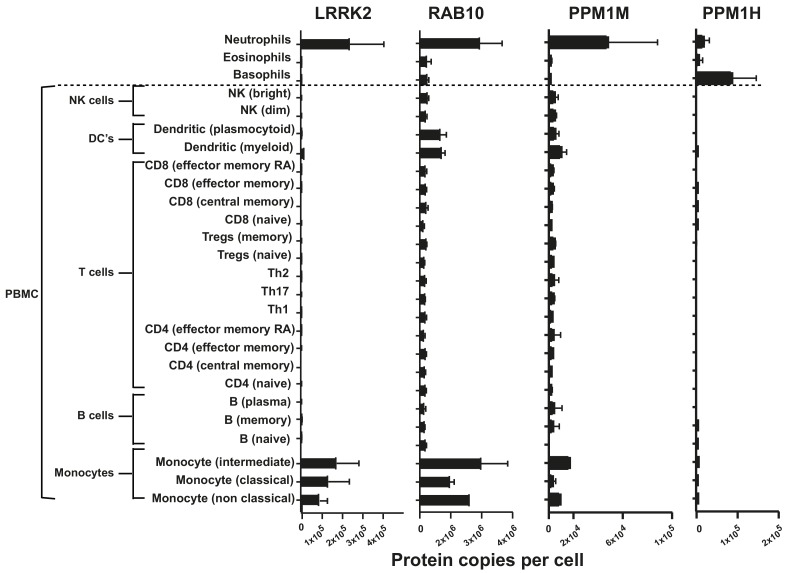
The abundance of PPM1H and PPM1M proteins in immune cells isolated from human blood using data available from the immprot database (http://www.immprot.org) (Rieckmann et al., 2017).The study utilized pure populations of immune cells isolated from human blood using fluorescence-activated cell sorting, and whole cell proteomics data were generated. Data were analyzed using the histone ruler to estimate protein copy numbers per cell. The graphs show the number of protein copies per cell for PPM1H, PPM1M, LRRK2 and Rab10 in a range of peripheral blood immune cells including subsets of T cells, B cells, monocytes, NK cells, dendritic cells and the granulocytes neutrophils, basophils and eosinophils.